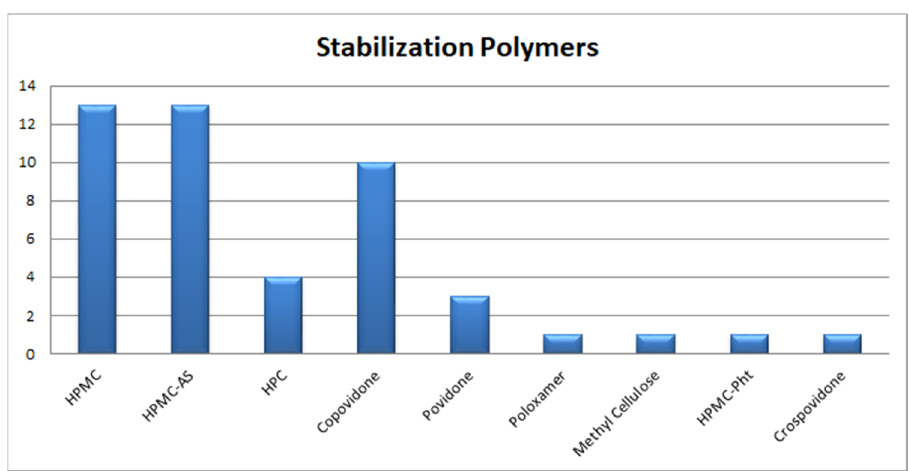
Figure 12. Number of marketed ASD products using different processes (source PharmaCircle™).